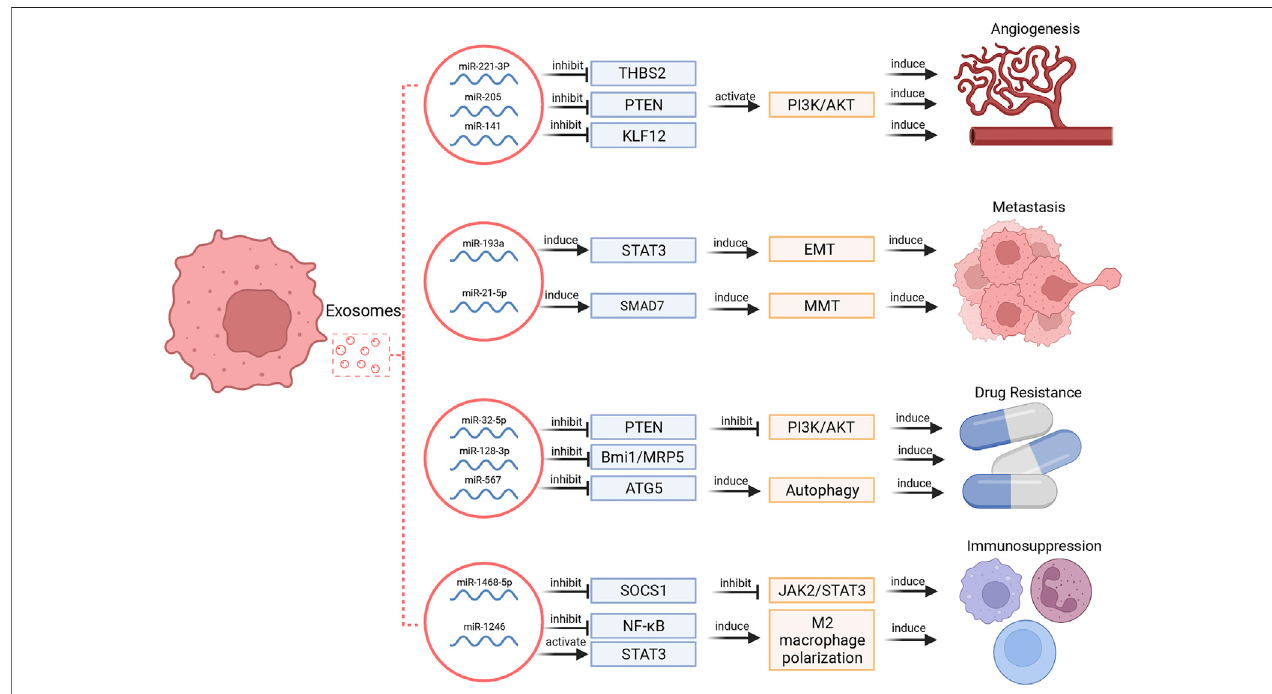
FIGURE 2 | Exosomal miRNAs regulate different hallmarks of cancers. These functions include regulation of angiogenesis, metastasis, drug resistance and immunosuppression.